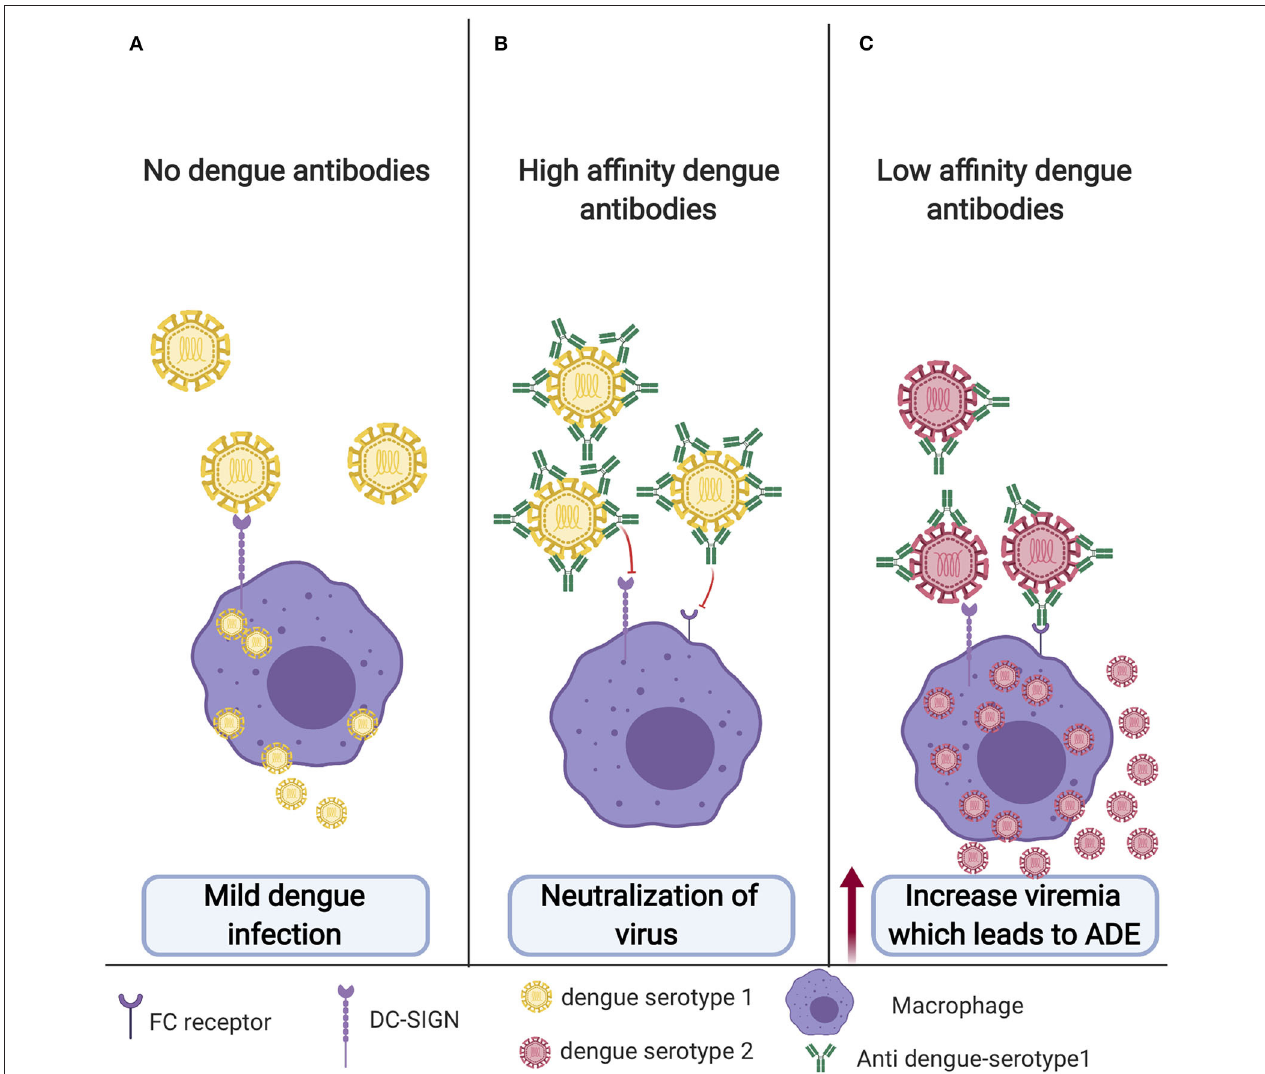
FIGURE 4 | Antibody dependent enhancement (ADE): (A) Primary infection with no previous vaccination. DENV will enter macrophage through its cognate receptor; however, most of the time, it will result in mild disease, and sometime this could even be symptomatic or with mild flu-like symptoms. (B) DENV in the presence of neutralizing antibodies for the same serotype. DENV will not be able to enter the cells and establish infection. (C) Cross-reactive antibodies from previous unsuccessful dengue vaccine or dengue infection with different serotypes will bind but not neutralize the virus. This low-affinity binding will facilitate the entry of the virus to the macrophage through FC receptor resulting in increased viremia leading to